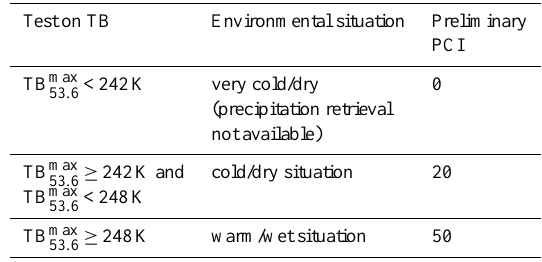
Table 1. Preliminary PCI thresholds based on screening algorithm.